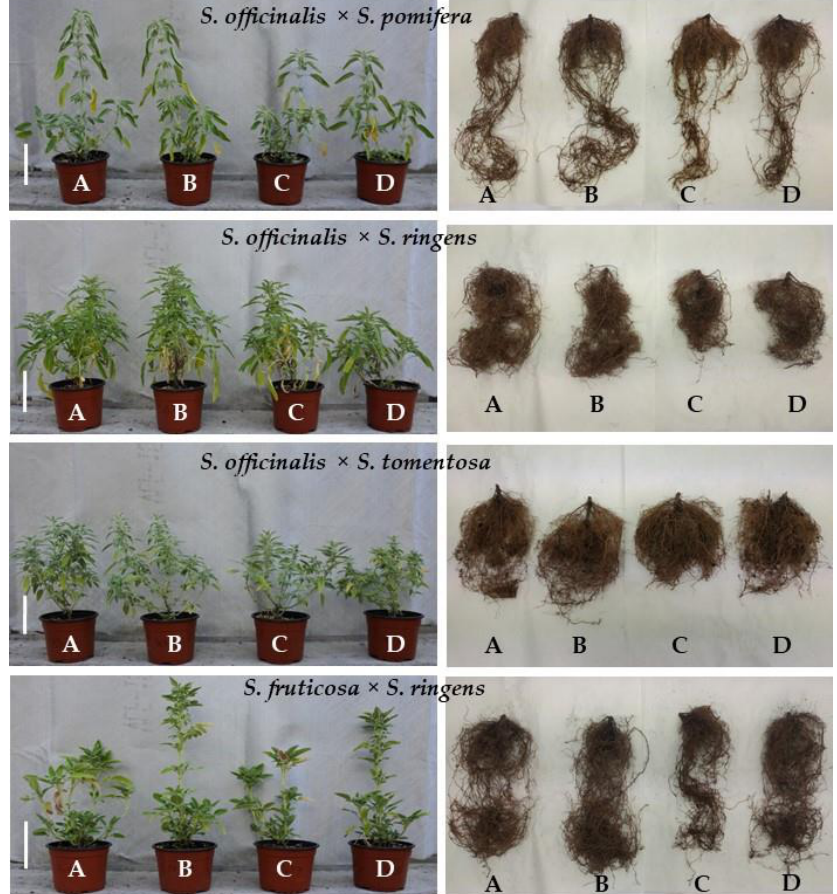
Figure 1. Typical above ground and root system of the marked hybrids of Greek sage species, after having grown for three months in greenhouse conditions (A: without and B: with 25 g/L attapulgite/normal irrigation, C: without and D: with 25 g/L attapulgite/sparse irrigation). Size bars = 10.0 cm.